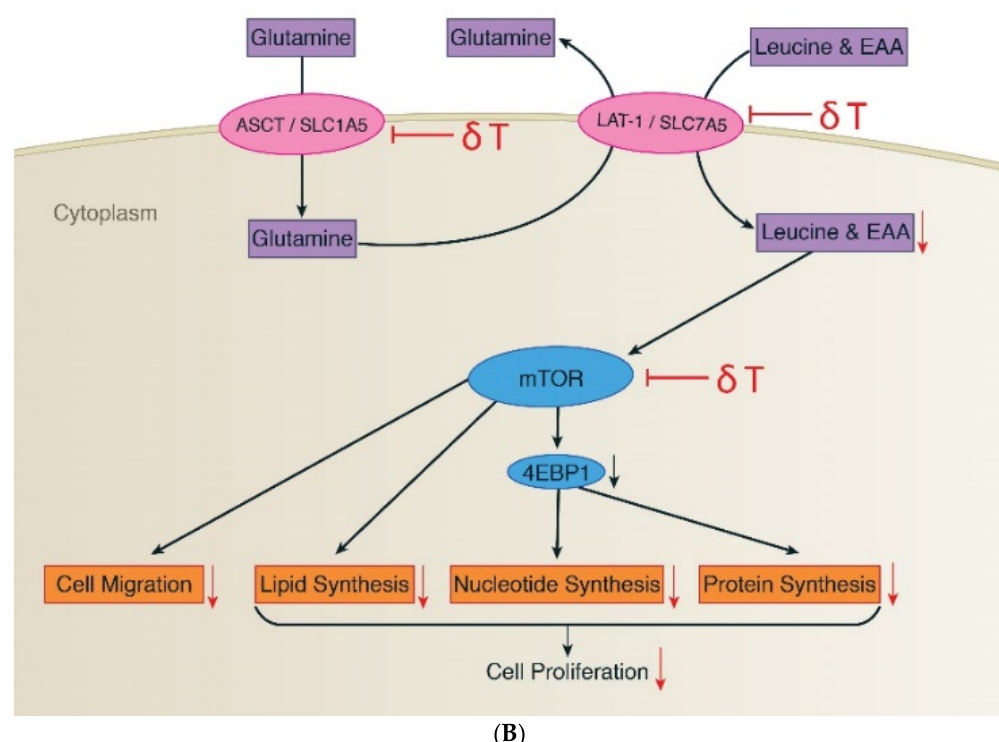
Figure 4. δT inhibits glutamine transporters (LAT-1 and ASCT2) and the mTOR pathway in A549 and H1299 cells. ( A ) The expressions of LAT-1, ASCT2, p-mTOR, mTOR, p-4EBP-1, 4EBP1, and β-actin proteins were detected by Western blot analysis in A549 and H1299 after treating with 0 µM and 30 µM concentrations of δT for 72 h. ( B ) The fate of glutamine uptake in A549 and H1299 involving metabolites (purple), associated key proteins (pink), and functions (orange). Glutamine in cancer facilitates exchanging of EAAs (essential amino acids) into proliferating cells via glutamine transporters (LAT1 and ASCT2), which induces mTOR activation in A549 and H1299. Activated mTOR then promotes protein translation and cell growth via activation of its downstream genes 4EBP1. The black arrows indicate pathway direction, while the red downward arrows indicate inhibition.